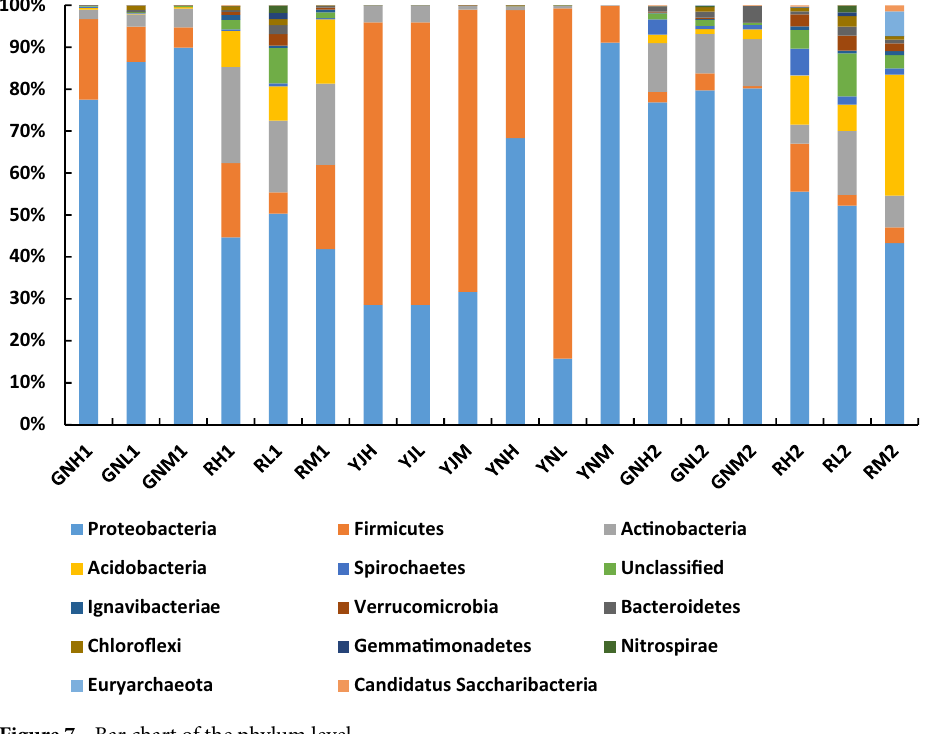
Figure 7. Bar chart of the phylum